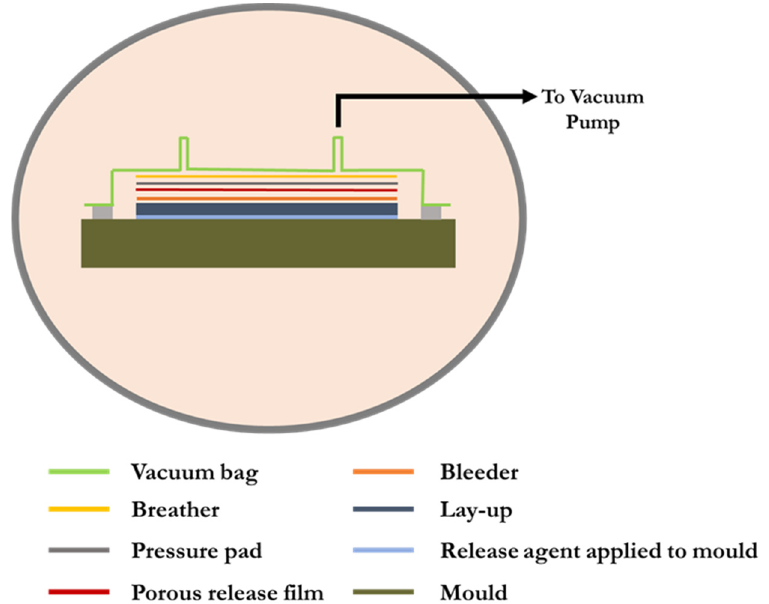
Figure 3. A typical autoclave moulding bagging mechanism.